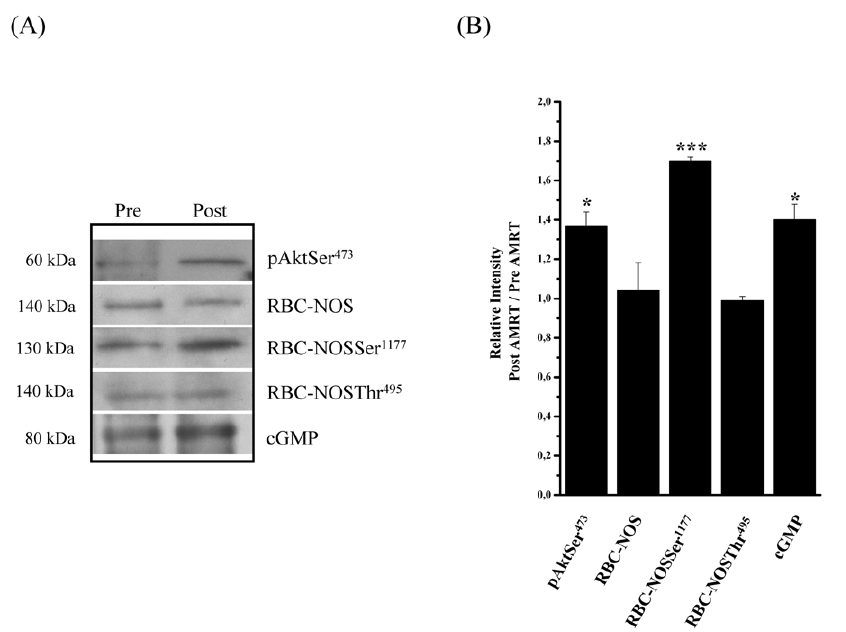
Figure 5. Change in phosphoAktSer 473 , RBC-NOS and cGMP before (Pre) and after (Post) AMRT determined by western blot analysis. (A) Specific representative bands for phosphoAktSer 473 , total detectable RBC-NOS, RBC-NOSSer 1177 , RBC-NOSThr 495 and cGMP migrated at 60kDa, 140kDa, 130kDa, 140kDa and 80kDa, respectively. PhosphoAktSer 473 , RBC-NOSSer 1177 and cGMP obtained Post-AMRT were significantly increased compared to Pre-AMRT. Bands obtained from total detectable RBC-NOS and RBC-NOSThr 495 remained unchanged. (B) Relative intensity obtained from western blot bands was significantly increased for phosphoAktSer 473 ( P , 0.05), RBC-NOSSer 1177 ( P , 0.001) and cGMP ( P , 0.05) Post- AMRT in relation to Pre- AMRT (set to ‘‘1’’). Relative intensity of total detectable RBC-NOS and RBC-NOSThr 495 remained unaltered. Data in (B) are presented as mean 6 S.E.M of n=6.